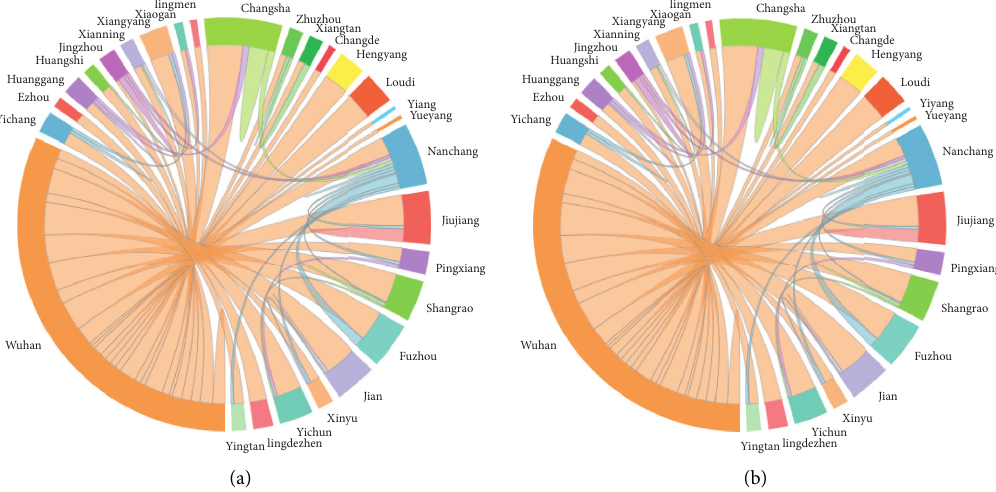
Figure 3: Freight connection flow diagram of urban agglomerations in the middle reaches of the Yangtze river in 2014 (a) and 2018 (b).